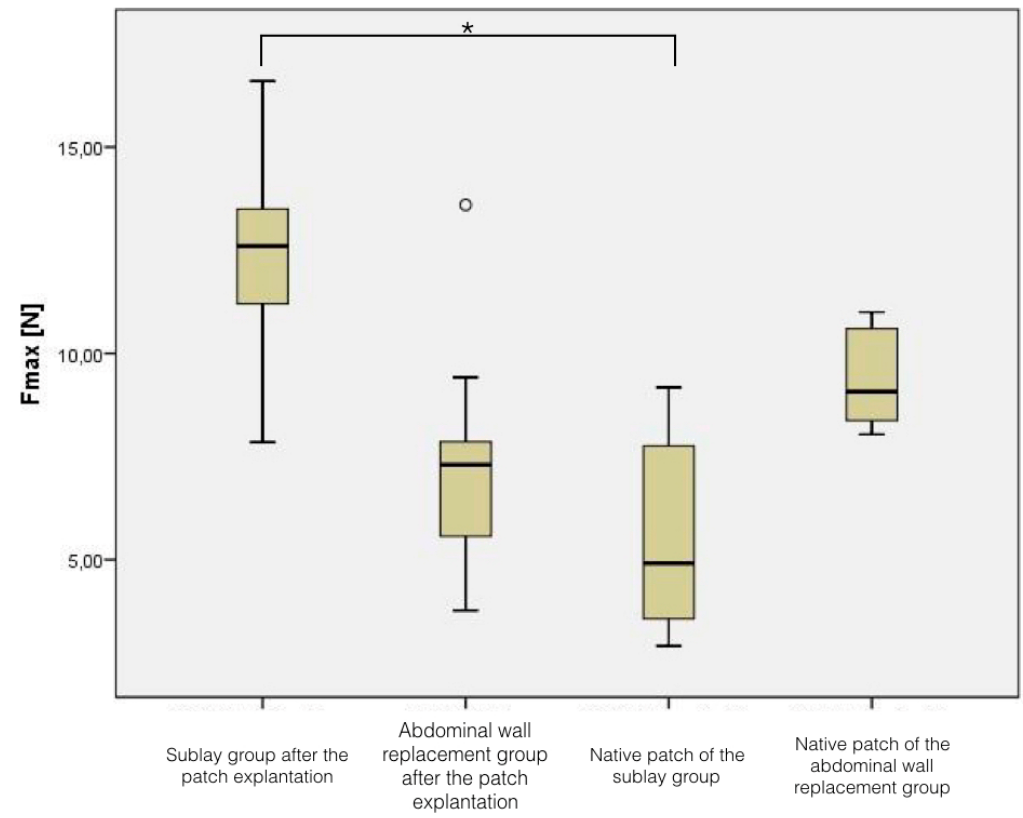
Figure 6. Tensile testing results depending on the group Figure 4. Tensile testing results depending on the group affiliation.